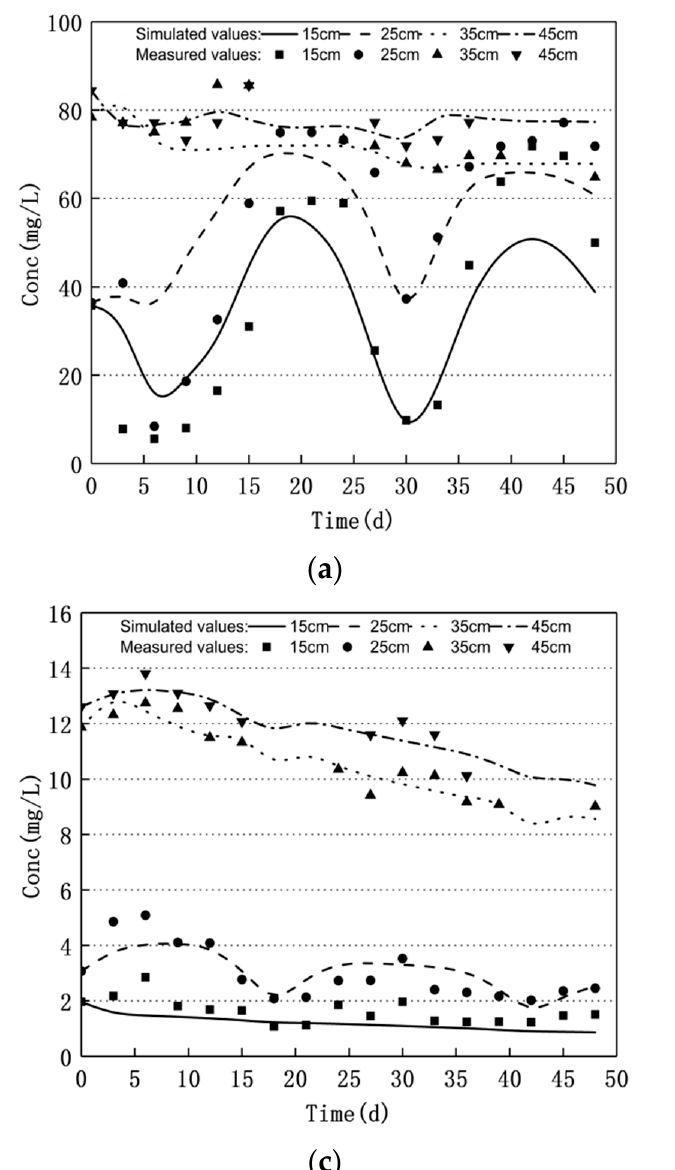
Figure 5. The process of nitrogen change in medium sand (( a ) nitrate nitrogen; ( b ) nitrite nitrogen; ( c ) ammonium nitrogen).